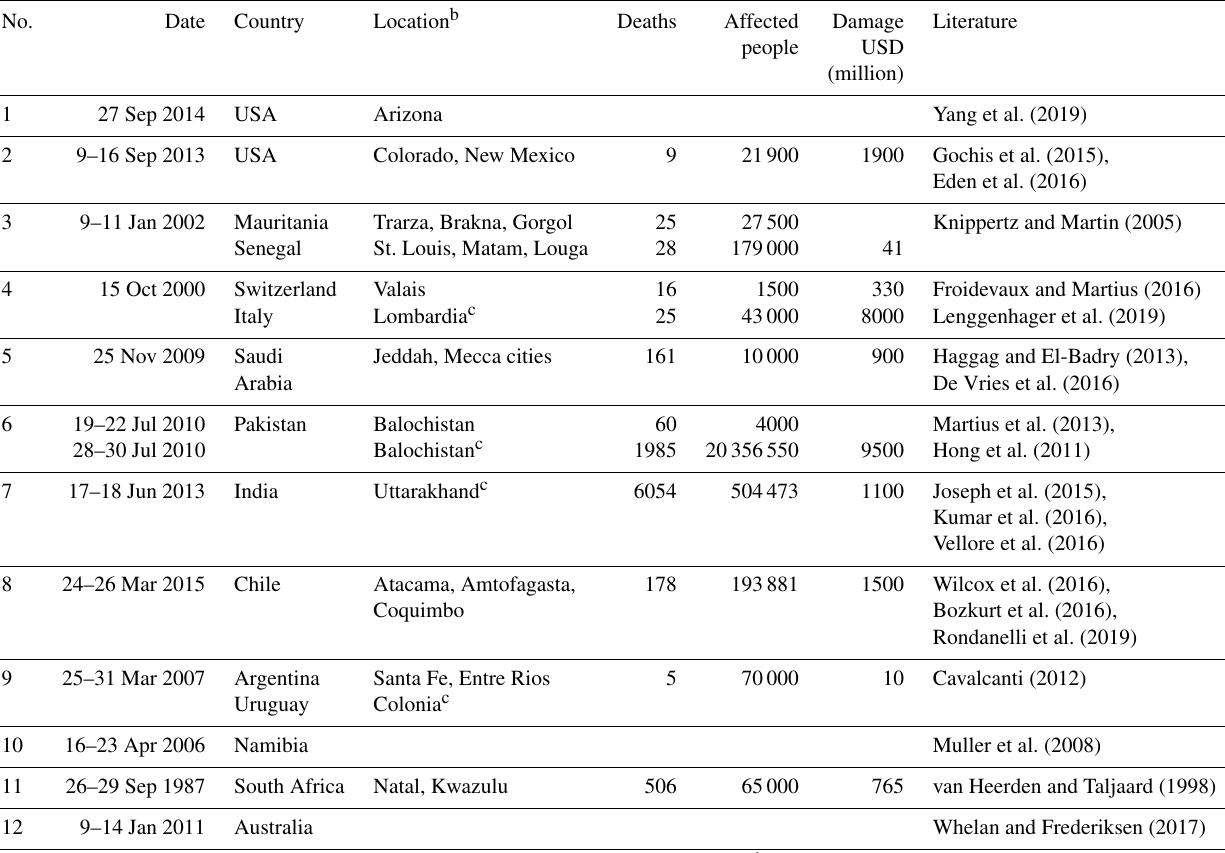
Table 2. Example cases of EPEs, flooding, and their socioeconomic impacts (EM-DAT) a .